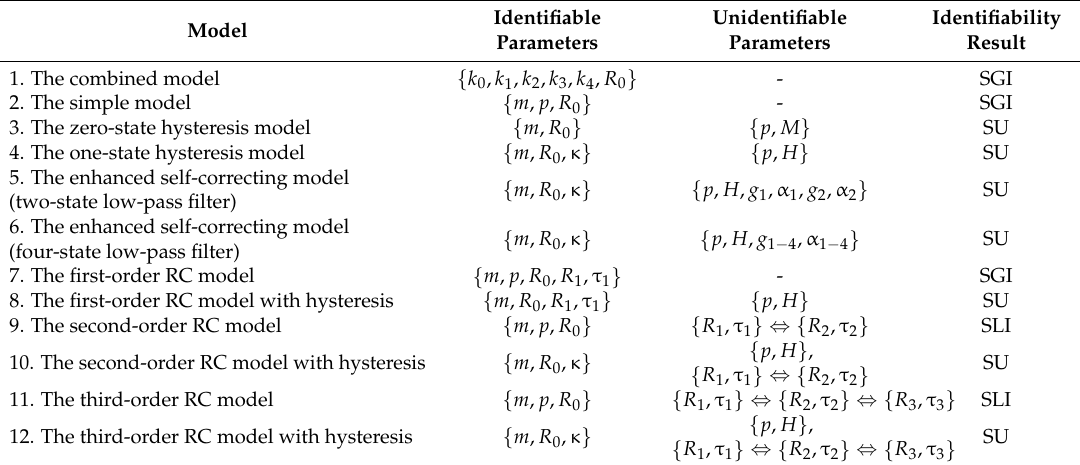
Table 2. Structural identifiability analyses